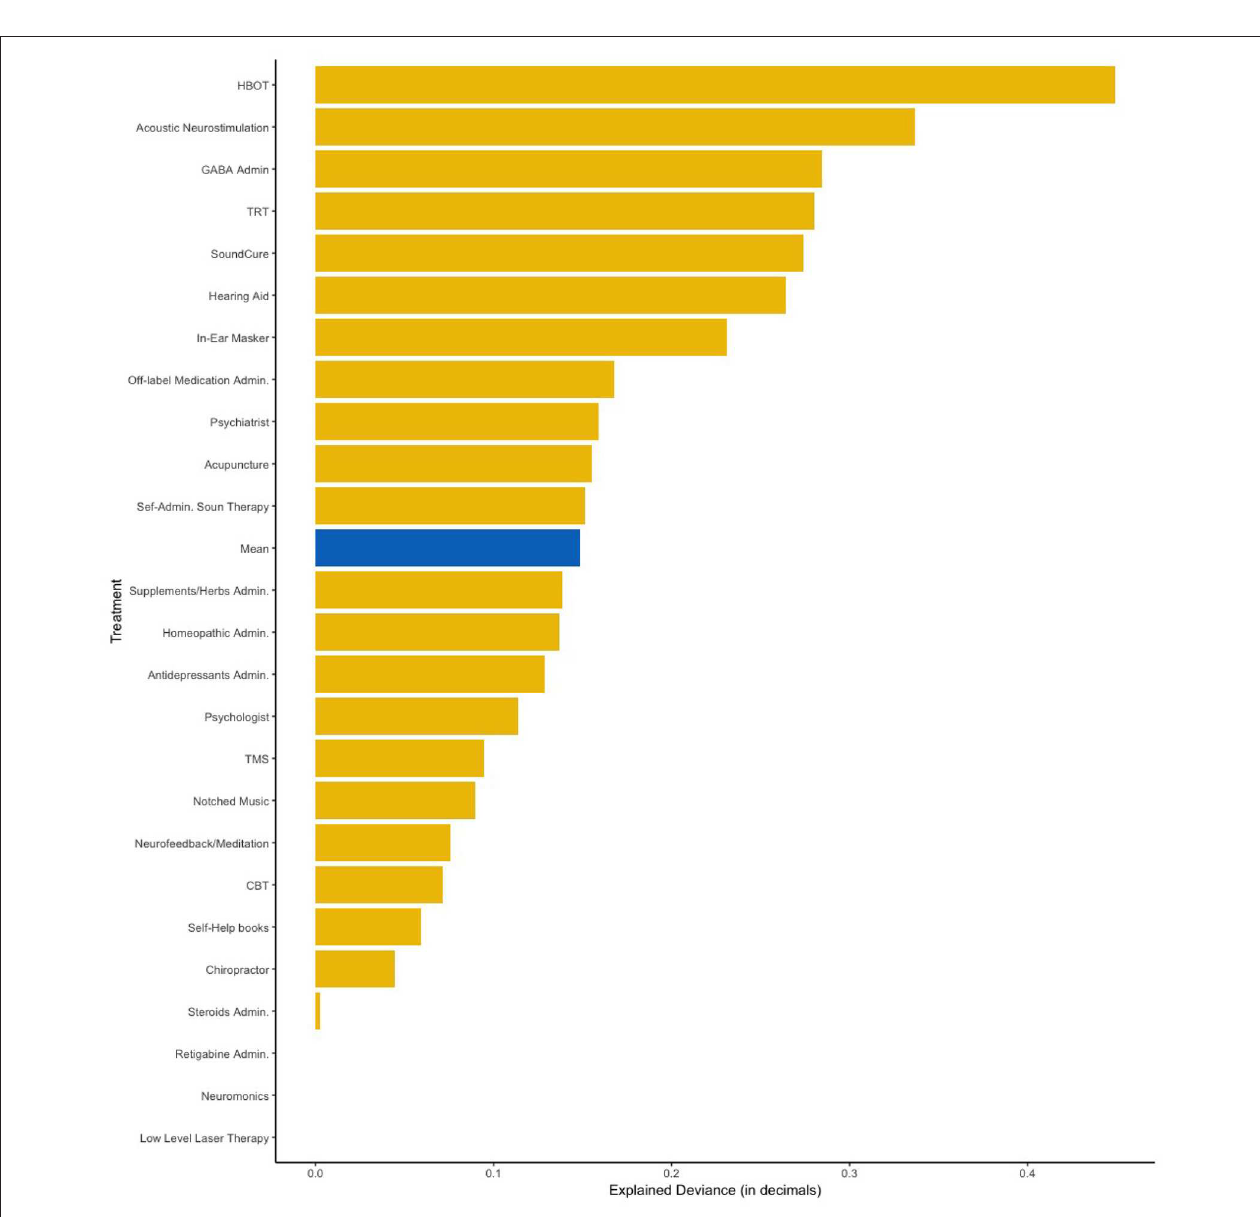
FIGURE 3 | Amount of variance explained by the Elastic Net model with all the 13 predictors added simultaneously. HBOT, Hyperbaric Oxygen Therapy; TRT, Tinnitus Retraining Therapy; TMS, Transcranial Magnetic Stimulation; CBT, Cognitive Behavior